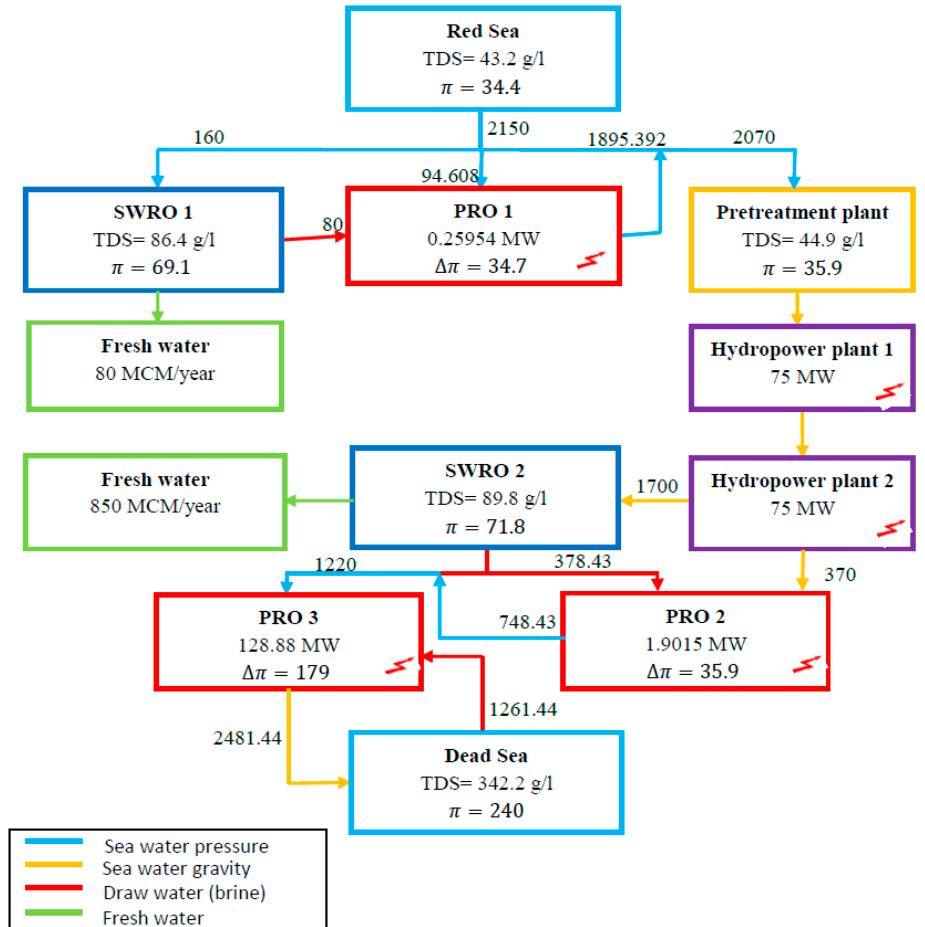
Figure 5. Flow chart of the flow streams for the proposed RSDS project and the three proposed PRO plants. (Flow rates are shown beside arrows [26]. All flow rates are in MCM/year). Table 2. Data for the three proposed PRO power plants.